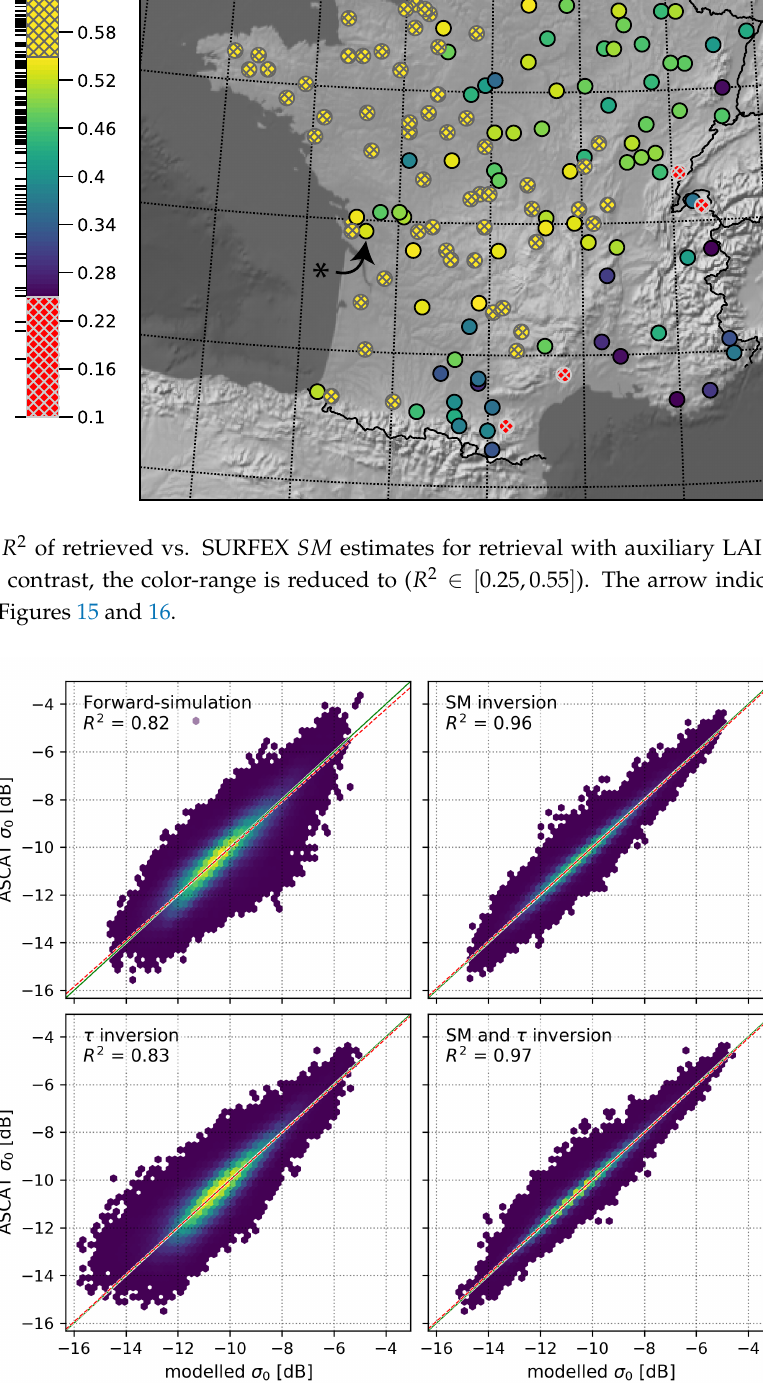
Figure 11. Scatterplots of modelled vs. measured σ 0 in dB for all four experiments. Each plot has been generated using the results from all all processed